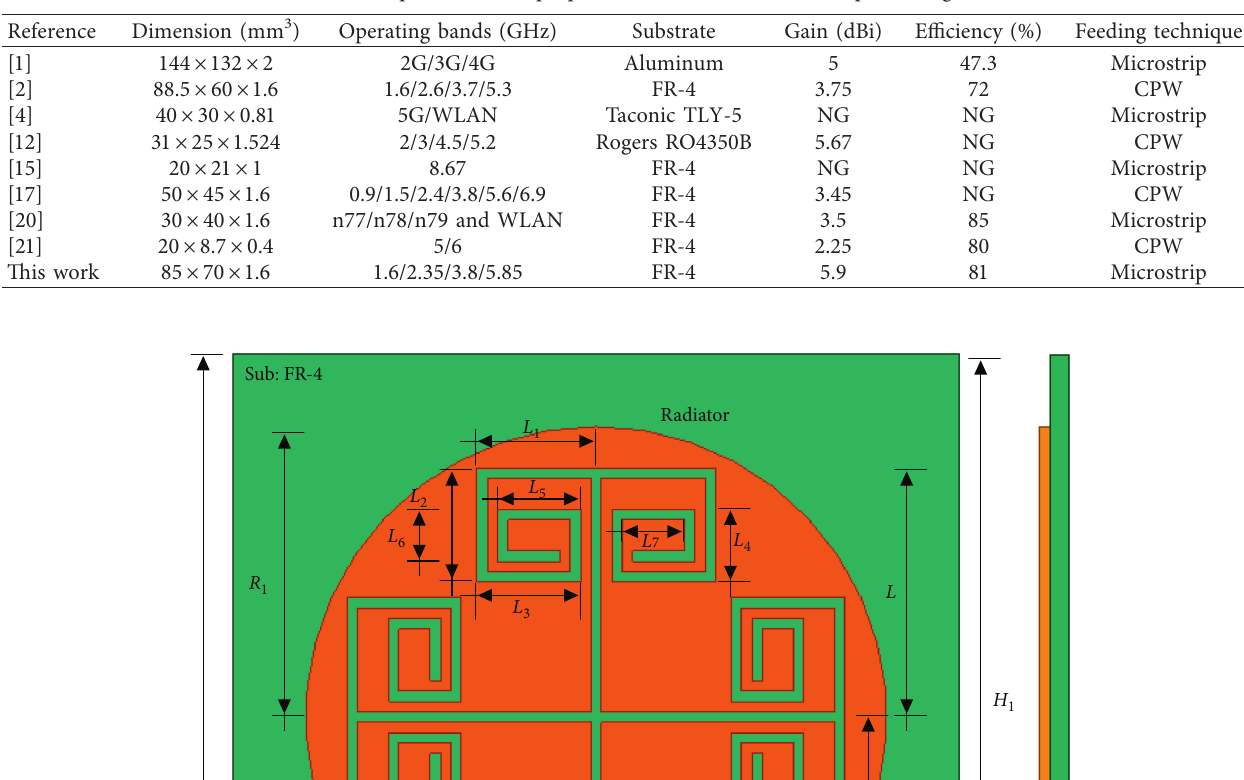
Table 1: Performance comparison of the proposed antenna with the recent pioneering state of the art.